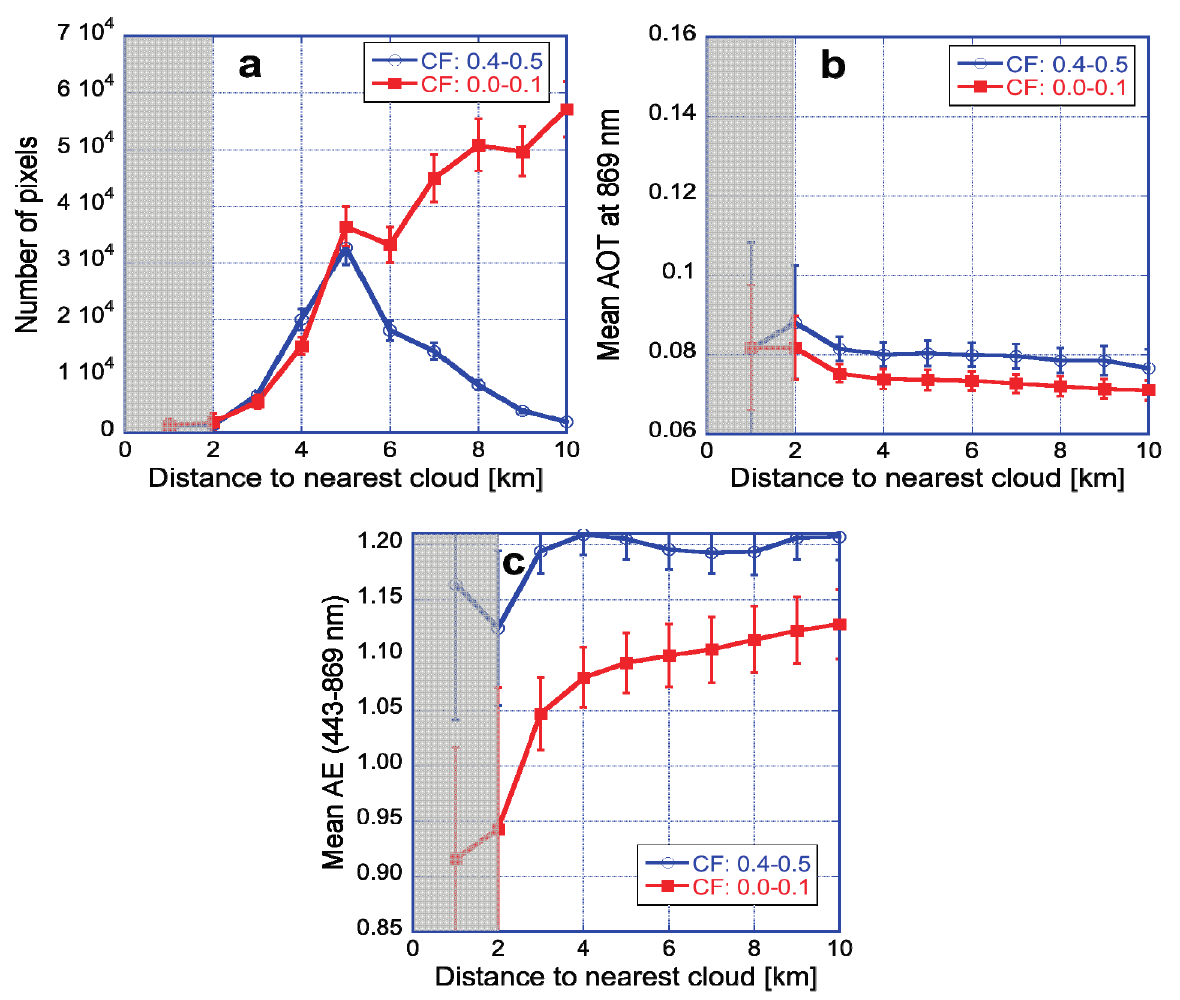
Figure 9. Same as Figure 3, but with the data selection using warnings by all QA flags. ( a ) Number of pixels; ( b ) Aerosol optical thickness; ( c ) Angstrom